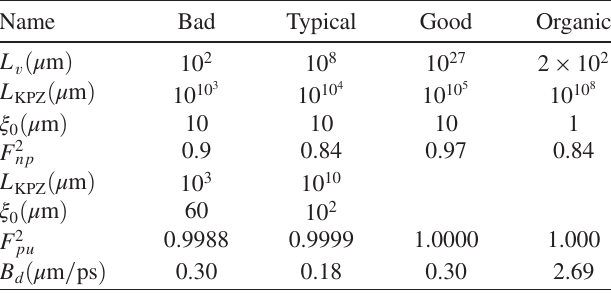
TABLE I. Comparison of different experimental microcavities. Each column contains details for one of the four different considered cavities: bad, typical, good, and organic samples 1 . 4 and k 0 . 1 . The first four rows indicate character- for k p ¼ s ¼ istic length scales for the vortex-dominated phase ( L ), for the v KPZ phase ð L , the healing length ( ξ 0 ), and normalized pump KPZ Þ ) at the point where L reaches the minimum value in power ( F 2 v pu the stable three-mode OPO region close to the upper threshold (region A in Fig. 2). The fifth, sixth, and seventh rows show L , KPZ 2 ≈ L ξ , where L , close to the upper threshold. The 0 , and F pu v KPZ blank spaces for the good and the organic samples mean that this crossing point occurs practically at the upper threshold. The last row shows the values of the drift term B in dimensional units, d which is approximately constant for the different values of the external drive (see Fig. 10 for the bad cavity case). It is clear that the KPZ length scale is unrealistic in regions A and C of the phase diagram presented in Fig. 2, leaving region B as the only potentially promising regime. FIG. 9. Regions potentially exhibiting a KPZ phase for differ- ent experimental microcavities. The KPZ nonlinearity parameter g (in a region where g > 1 ) is shown as a function of the normalized pump strength F 2 bad (blue line), typical (red dots), good (black dots), and organic (green dots) cavities. We present the regions that could potentially show KPZ scaling at all length scales beyond the healing length, i.e., g > 1 and Γ > 1 (see Sec. IVA). The dashed horizontal line marks the g ¼ 1 border, whereas the dashed vertical line indicates the normalized lower mean-field threshold, i.e., F 2 that only for the bad cavity is the three-mode ansatz stable in the region shown. In this plot, we consider k the bad and good cavities and k typical and organic